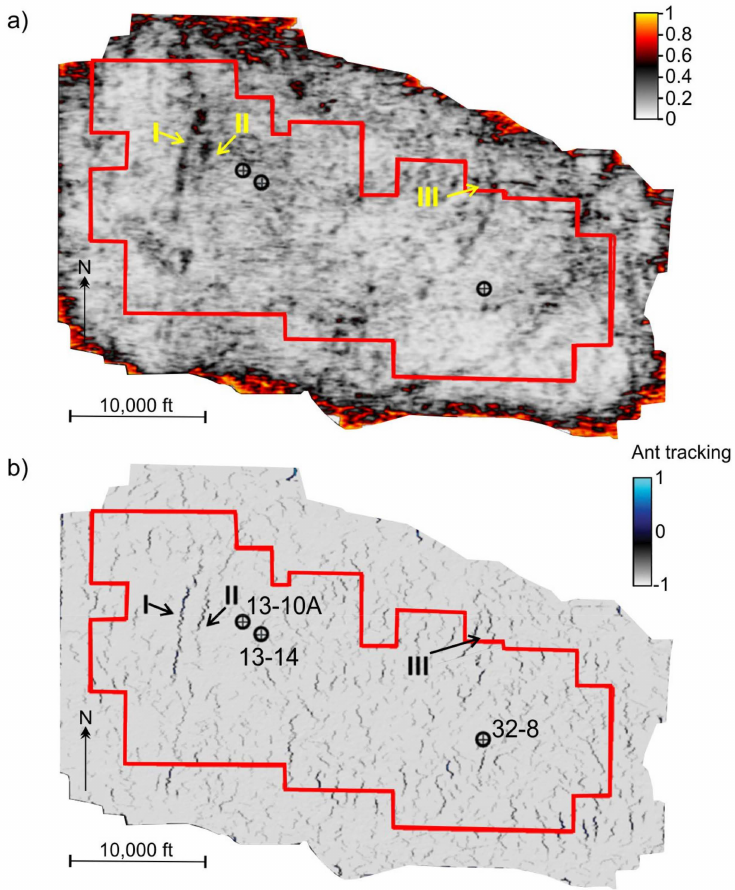
Figure 6. The Morrow B surface displaying the three characterization wells 13-10A, 13-14, and 32-8; ( a ) the Variance attribute overlain on the Morrow B surface; and ( b ) the Ant Tracking attribute overlain on the Ant Tracking volume. Features discussed in text are labeled as I, II, and III. In ( a ), the concentric rings in the eastern side of the survey have not been identified in other attributes and there is no evidence that they are geologic